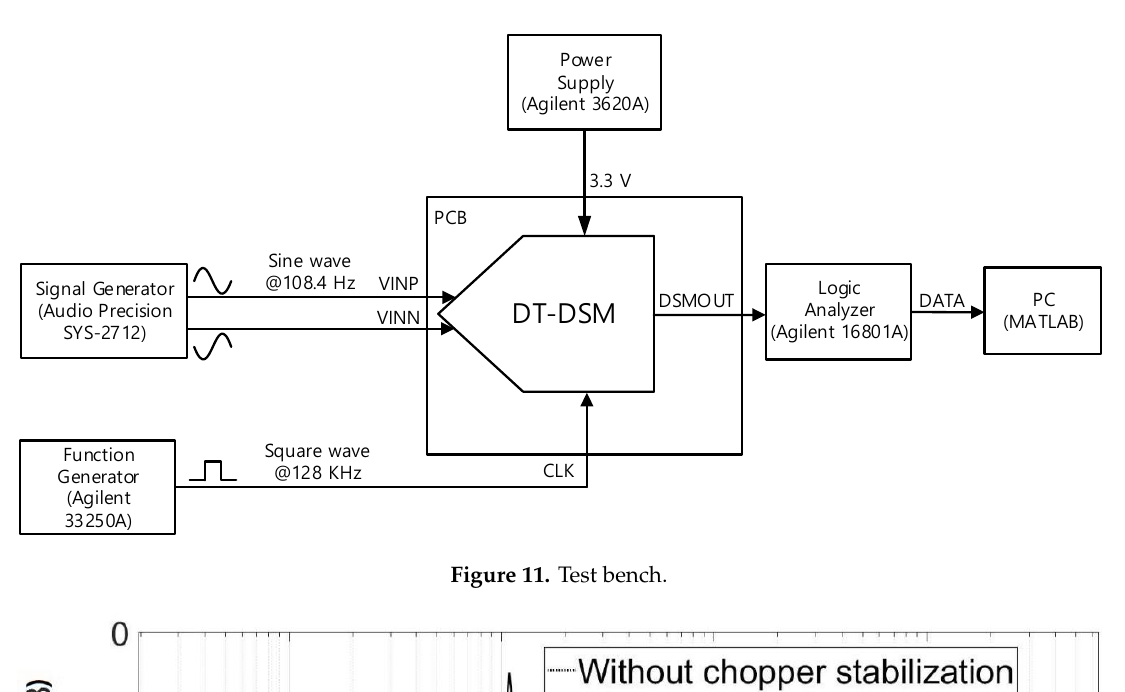
Figure 11. Test bench.